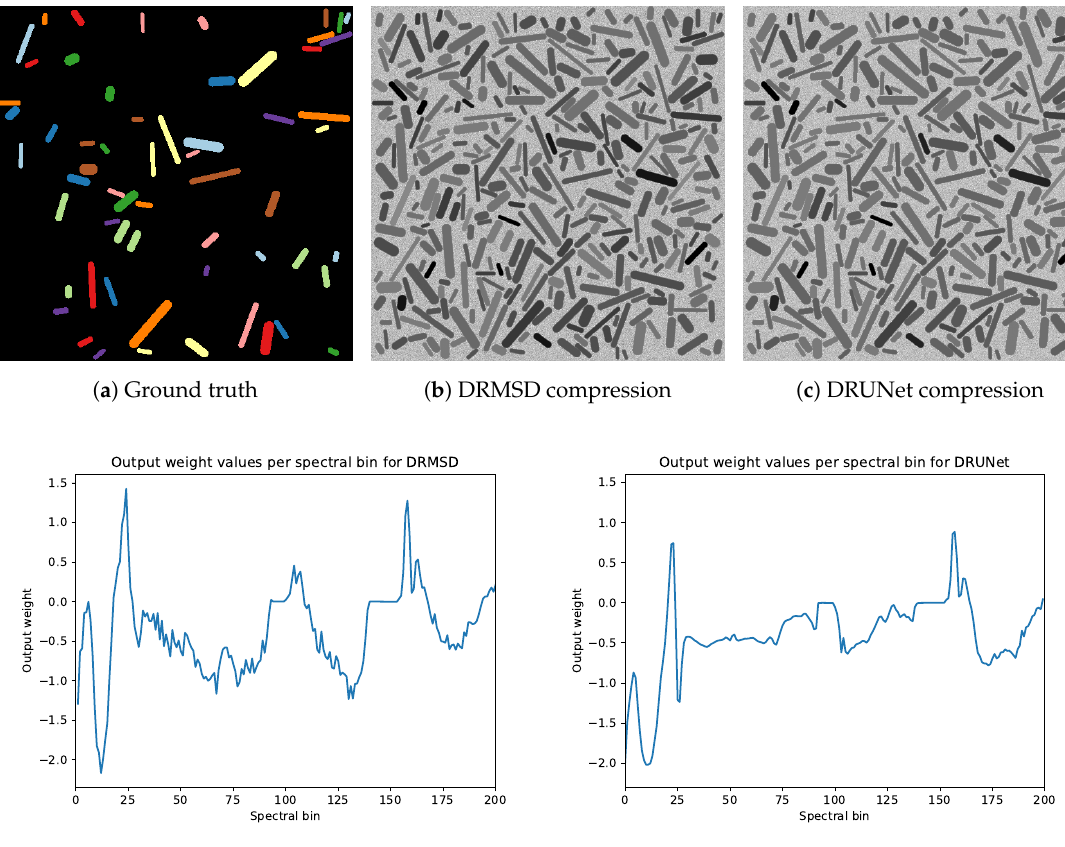
Figure 19. Example of data reduction weights ( d , e ) and resulting compressions (compare with ground truth ( a )) for DRMSD ( b ) and DRMSD ( c ) with reduction to one feature map channel for the noisy remote dataset without